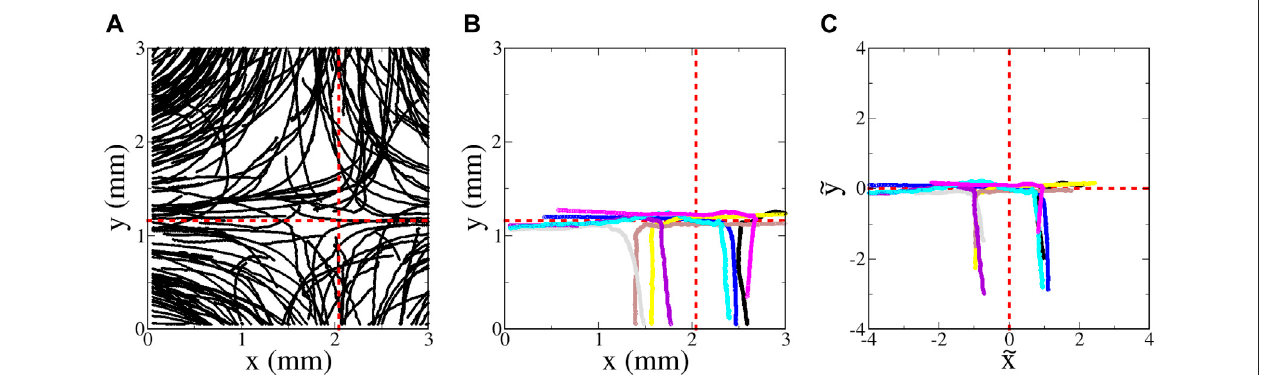
FIGURE 7 | Euglena swimming in a hyperbolic fl ow with A = 1.8 s − 1 ( fl ow rate 0.100 ml/min). (A movie showing the motion of the euglena can be found online with Supplementary Material ) (A) Random sampling of a very small subset of the trajectories. (B) Sampling of eight of the longest-duration trajectories with minimal tumblingthatenteredtheregionfromthebottom. (C) Sameas (B) ,butplottedusingnon-dimensionalvariables ~ x and ~ y .Inallofthepanels,thereddashedlinesshowthe location of the passive invariant manifolds going through the passive fi xed point of the hyperbolic fl